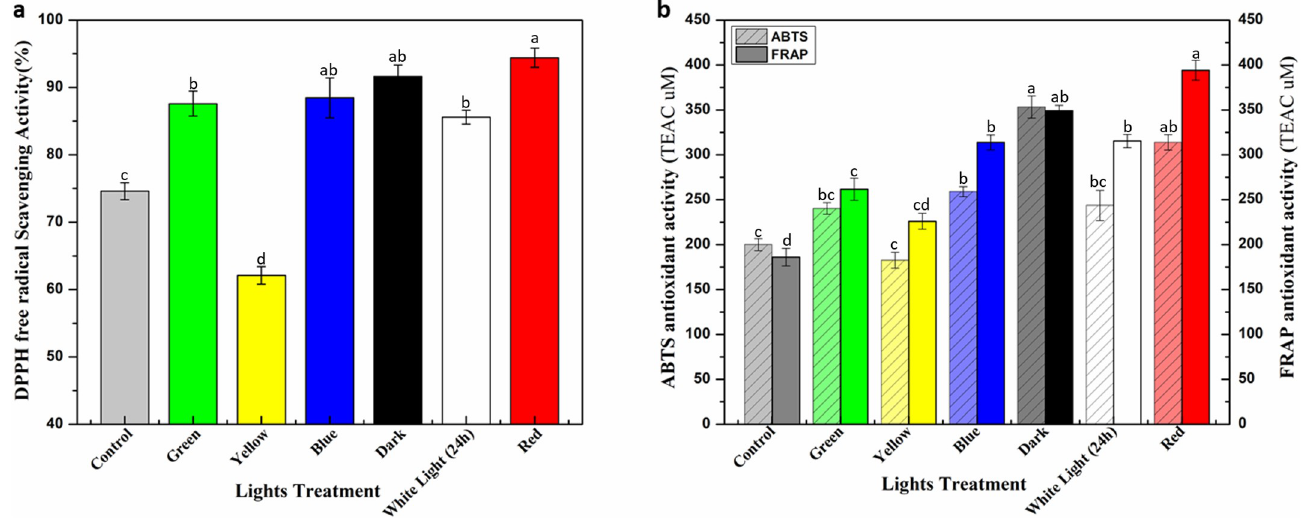
Fig 4. In vitro antioxidant activities of callus culture of E . alba a) DPPH (%), b) ABTS and FRAP assay (TEAC: Trolox C equivalent antioxidant activity, expressed in μ M.